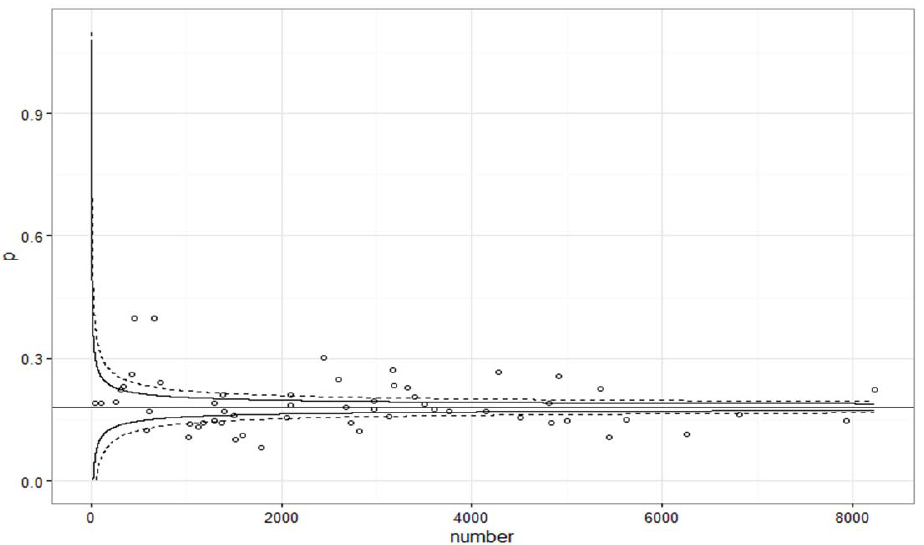
Figure 1. Number of prescriptions by neurologists and psychiatrists in the German federal state of Saarland plotted against the proportion of medication with third level. Practices are units of observation. Control limits were calculated according to Ieva and Paganoni and Spiegelhalter [8,23]. The solid horizontal line represents Huber’s M estimator, a robust substitute for the mean.